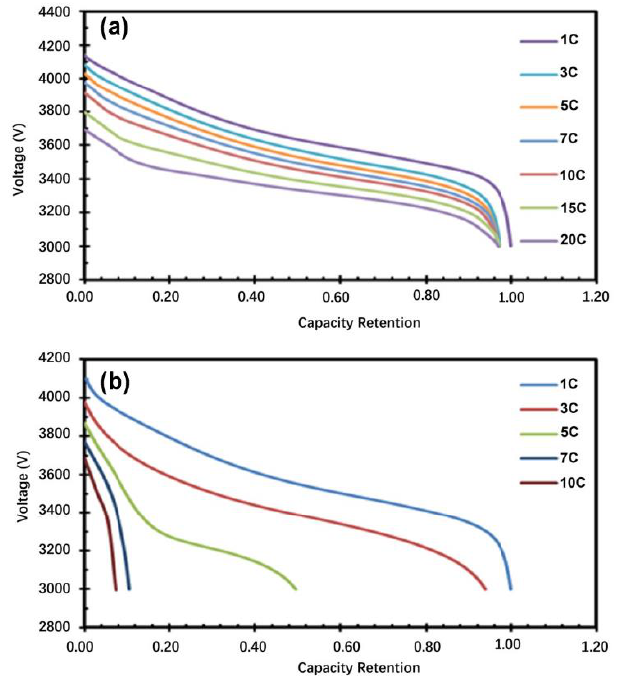
Figure 6. Discharge curves at different rates: ( a ) electrode thickness of 26.2 µ m; ( b ) electrode thickness of 71.8 µ m.